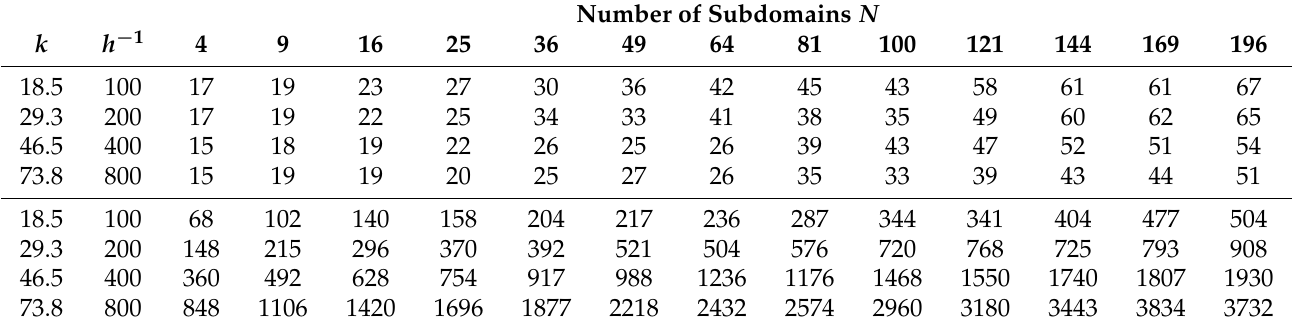
Table 9. Preconditioned GMRES iteration counts (above) and size of coarse space (below) for the homogeneous problem when using ORAS with impedance-H-GenEO (the eigenproblem (19) is altered to have impedance as opposed to Neumann boundary conditions on the left-hand side) and a varying number of subdomains. A uniform decomposition into is